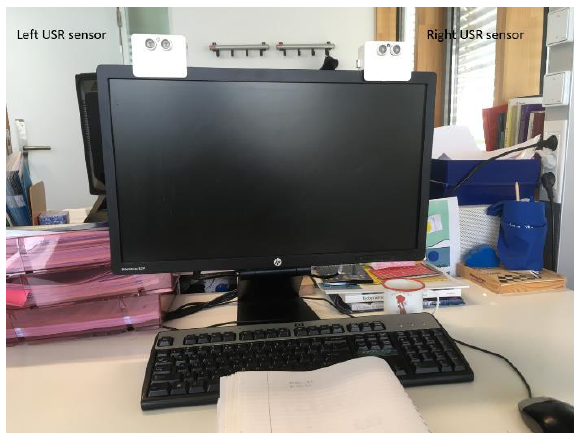
Figure 5. Photo of the set-up installation. Both sensors were mounted at the top edges of the computer screen. A commercial laptop was used to record user activity to obtain the ground truth.